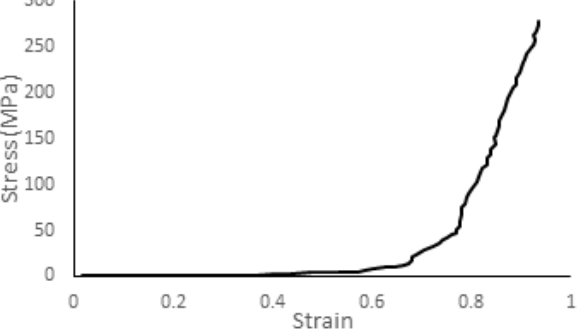
Figure 7. Stress–strain curve of the neoprene from uniaxial compression tests [49].